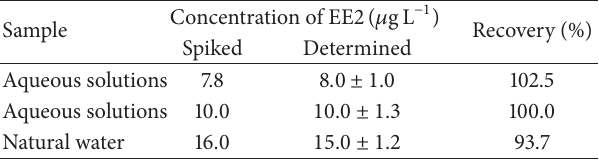
Table 1: Validation tests for accuracy of the method in water.